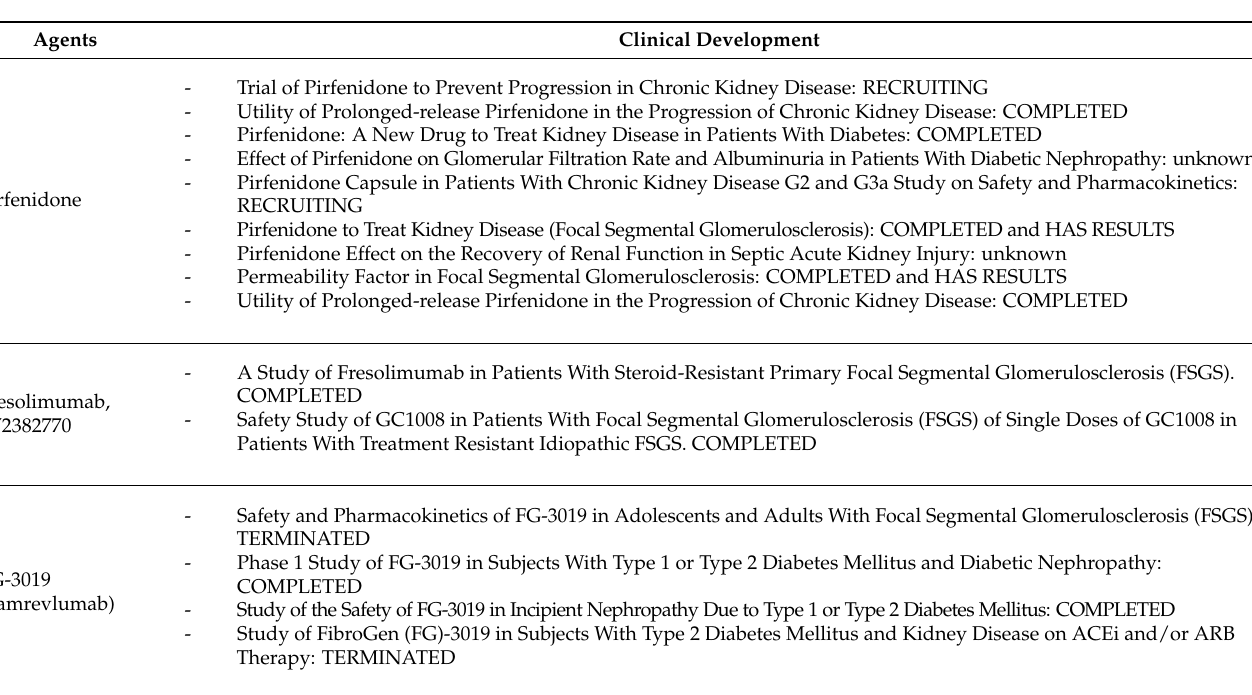
Table 1. 2022 status of drugs in clinical development for kidney fibrosis (status of each study is reported as recorded on ClinicalTrials.gov, accessed on 20 October